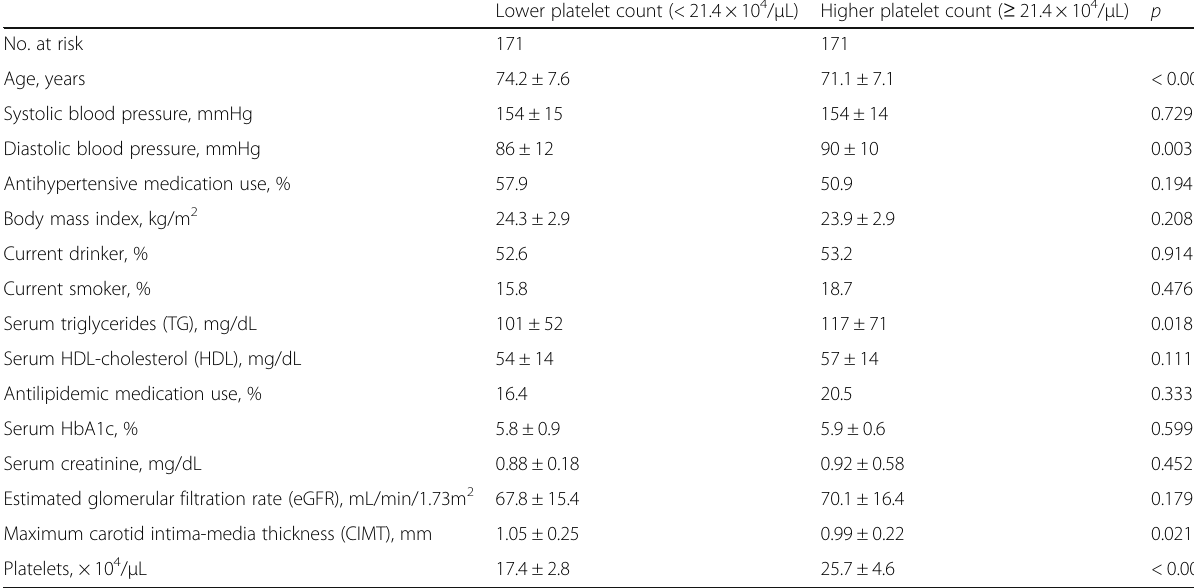
Table 1 Platelet level-specific characteristics of the study population